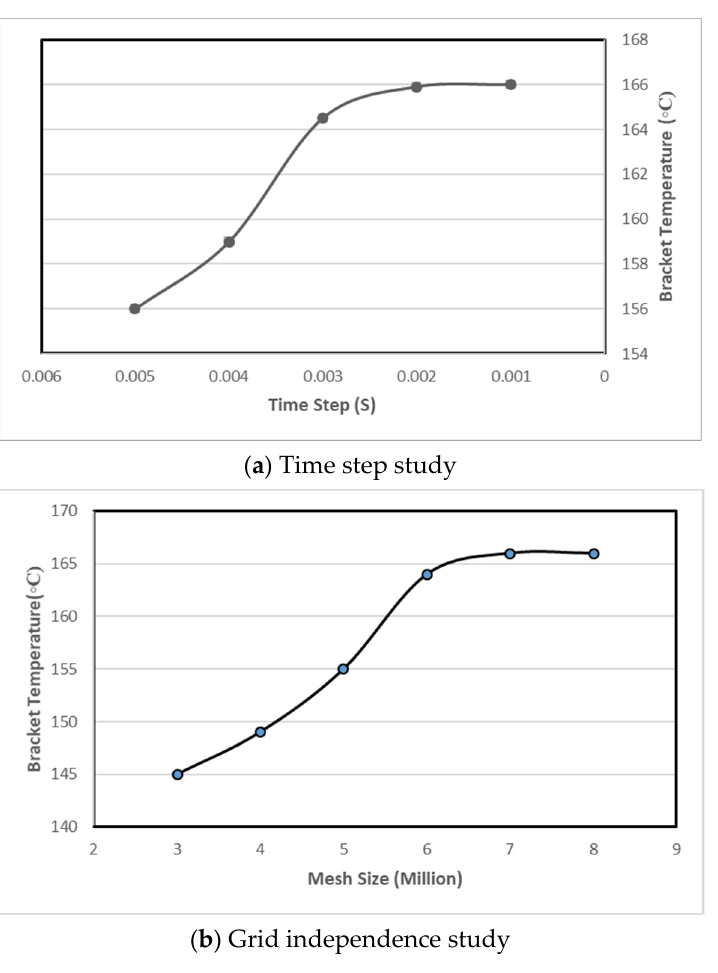
Figure 8. Solution independent studies.